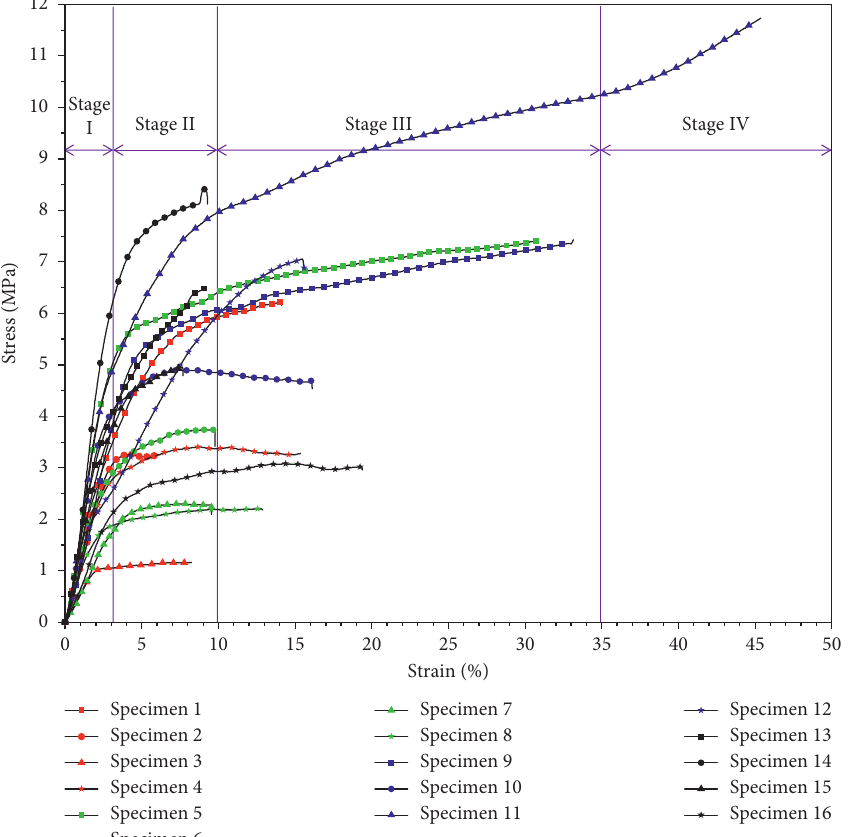
Figure 5: The stress-strain curves of PCS under uniaxial